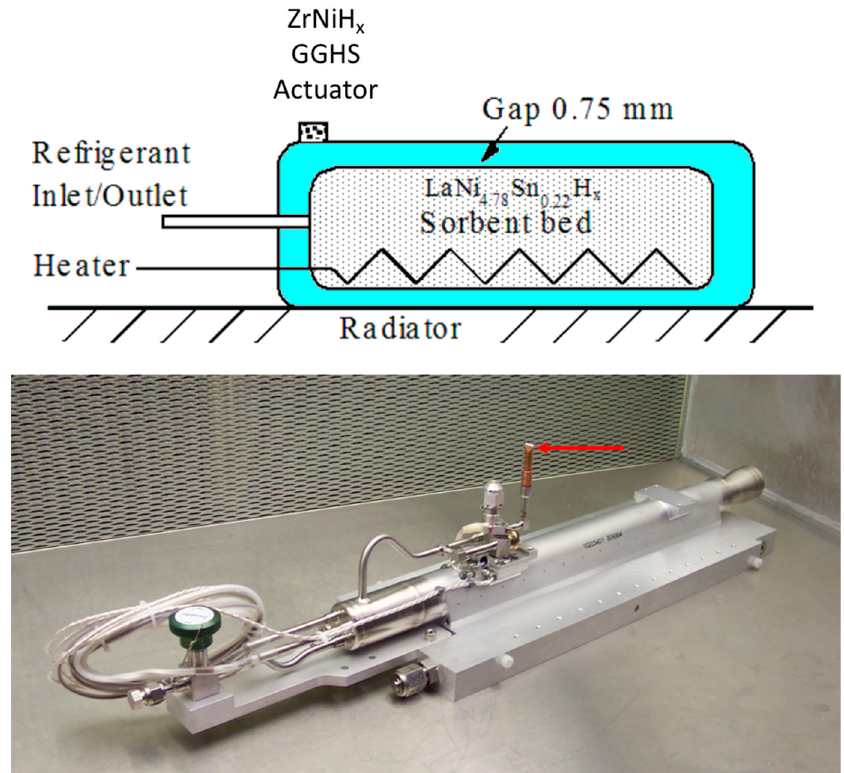
Figure 4. Upper: Schematic of a Planck Sorption Cryocooler (PSC) hydride compressor element (CE); lower: photograph of a completed flight CE mounted on a temporary thermal testing plate where the red arrow points to the location of the pinch-off weld closure for the Gas-Gap Heat Switch (GGHS). Six compressor elements were fabricated for each of the two PSC flight units identified as FM1 and FM2. Separate lots of the LaNi 4.78 Sn 0.22 alloys were produced by the Ames Laboratory at Iowa State University (Ames, IA, USA) using zone refined high purity La, Ni, and Sn metals via small batch arc-melting synthesis followed by nominal 100 h of annealing at 950 °C under gettered argon gas.